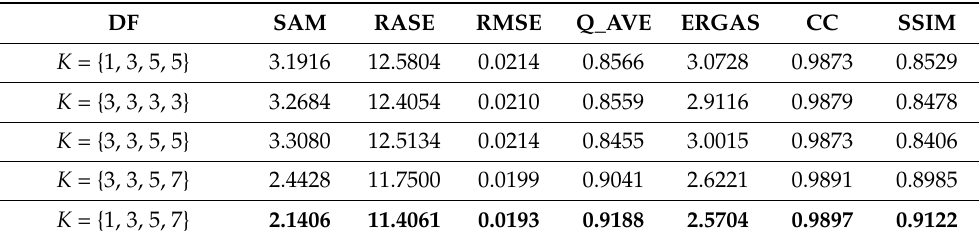
Table 8. Quantitative assessment results of multiscale feature extraction module. The best perfor- mance is shown in